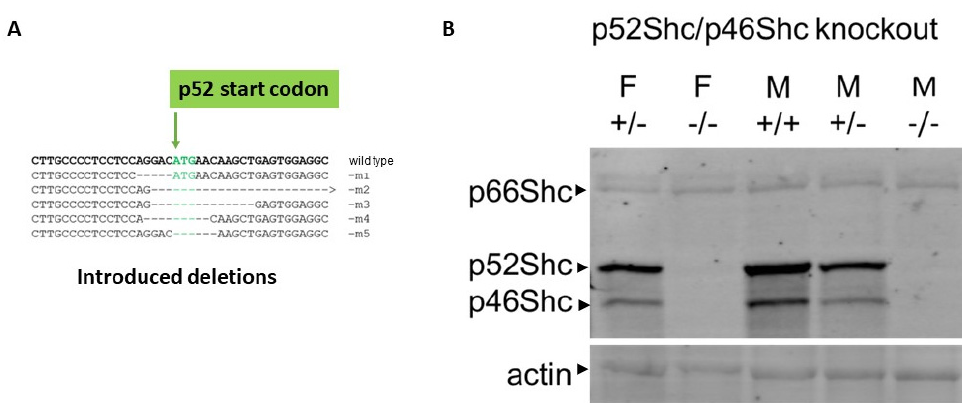
Figure 1. Generation and characterization of rats deficient in Shc isoform expression. ( A ) Introduced deletions into Shc1 gene. The position of p52Shc start codon is indicated. ( B ) Protein expression of Shc isoforms in wild type (WT) and genetically modified rats. Expression of three Shc isoforms in renal tissues of wild type (+/+), heterozygote (+/ − ) and p52Shc/p46Shc knockout ( − / − ) rats is shown by Western blot with anti-Shc antibodies following SDS-PAGE. The position of Shc isoforms is indicated. Equal loading was verified by anti- β -actin antibodies.